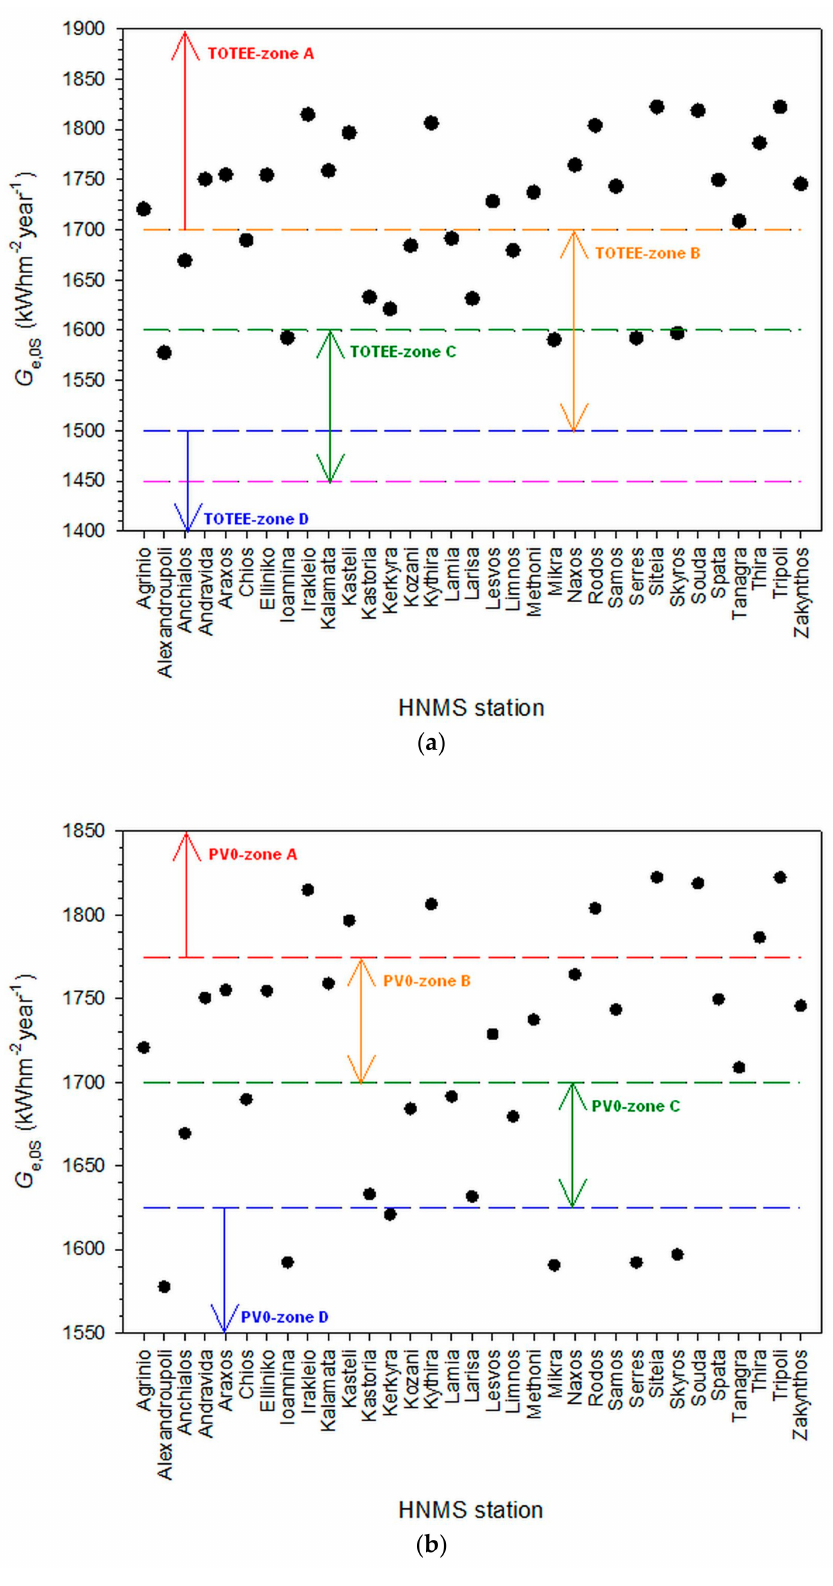
Figure 3. Solar energy yield per year on a horizontal plane G e, 0 S at each selected site of the HNMS meteorological network. The graph includes ( a ) the four TOTEE zones and ( b ) the four PV 0 zones, shown by single-arrowhead or double-arrowhead